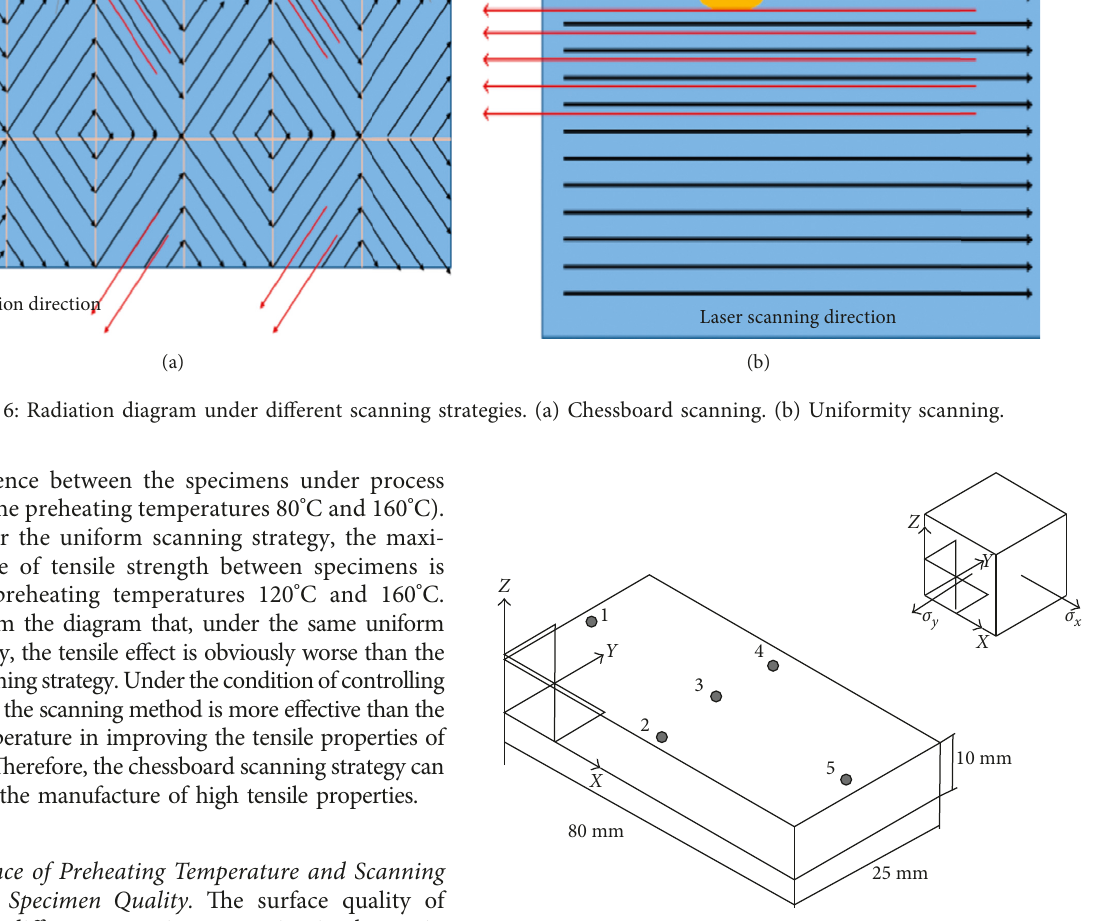
Figure 7: Distribution of test points and stress direction of single